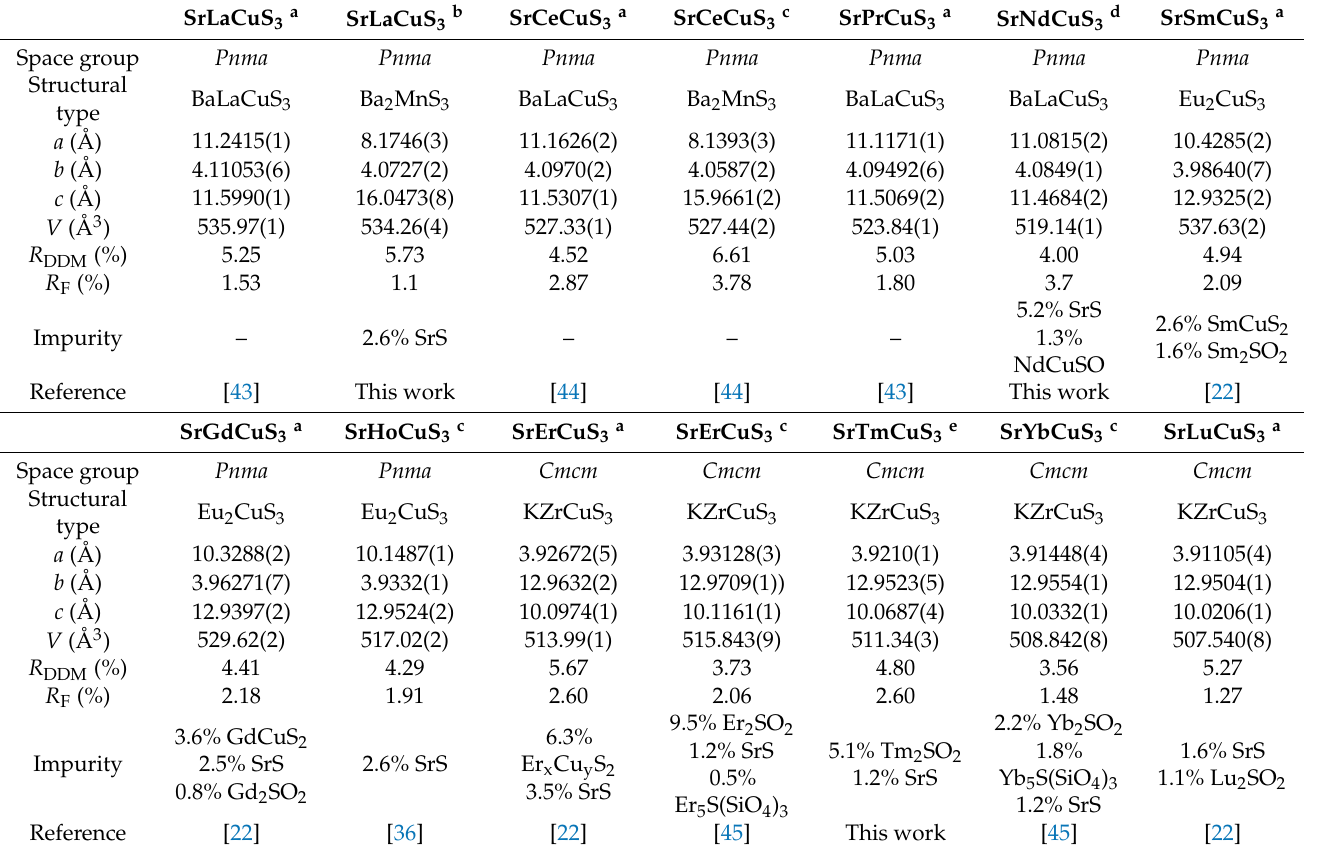
Table 2. Experimental details for the structures of SrLnCuS 3 , solved from the powder X-ray diffrac- tion